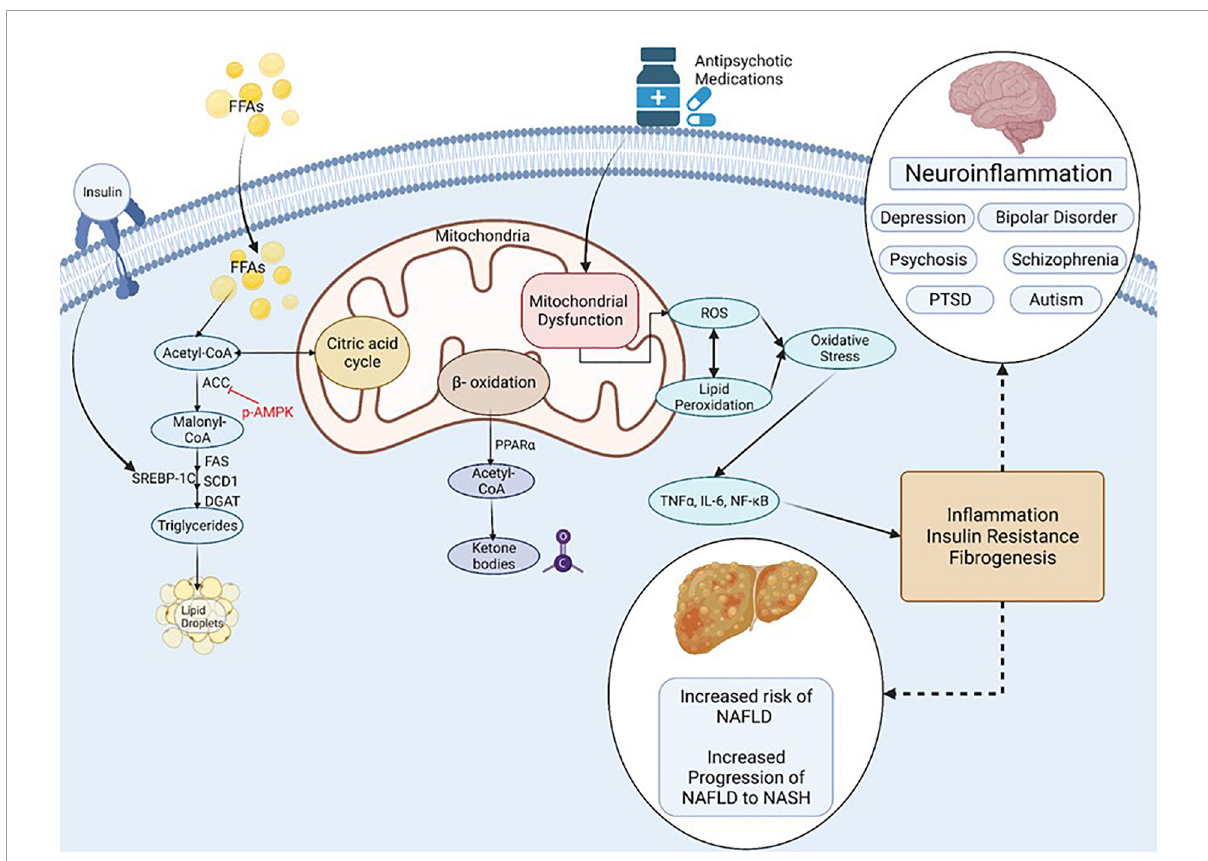
FIGURE4 Inflammation, Oxidative Stress and Mitochondrial Dysfunction are Unifying Mechanisms underlying NAFLD and Mental Illness. NAFLD, non-alcoholic fatty liver disease; NASH, non-alcoholic steatohepatitis; PTSD, post-traumatic stress syndrome; FFA, non-esterified (free) fatty acids; ROS, reactive oxygen species; ACC, Acetyl-CoA carboxylase; DGAT, diacylglycerol acyltransferases; SCD1, Stearoyl-CoA desaturase-1; FAS, Fatty acid synthase; SREBP-1C, Sterol Regulatory Element Binding Protein 1c; PPAR, Peroxisome proliferator-activated receptor; TNF, tumor necrosis factor; IL-6, Interleukin-6; NF-kB, Nuclear Factor-Kappa B. Figure created with